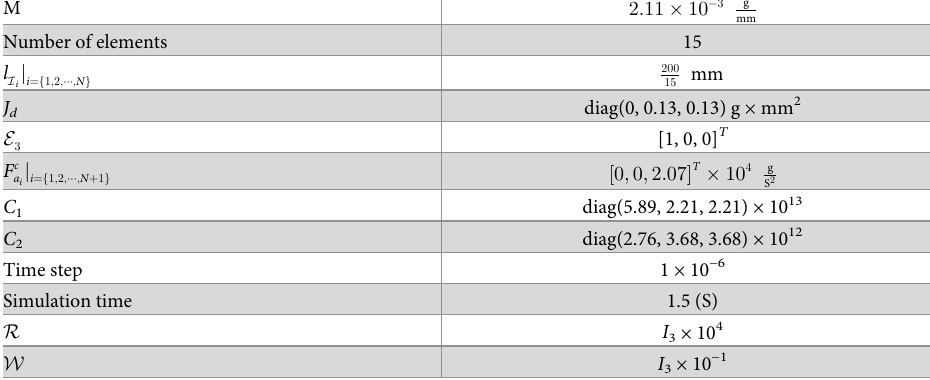
Table 4. Simulation parameters in Eqs (10)–(16)and (21) for out-of-plane experiment of flexible cylindrical rod